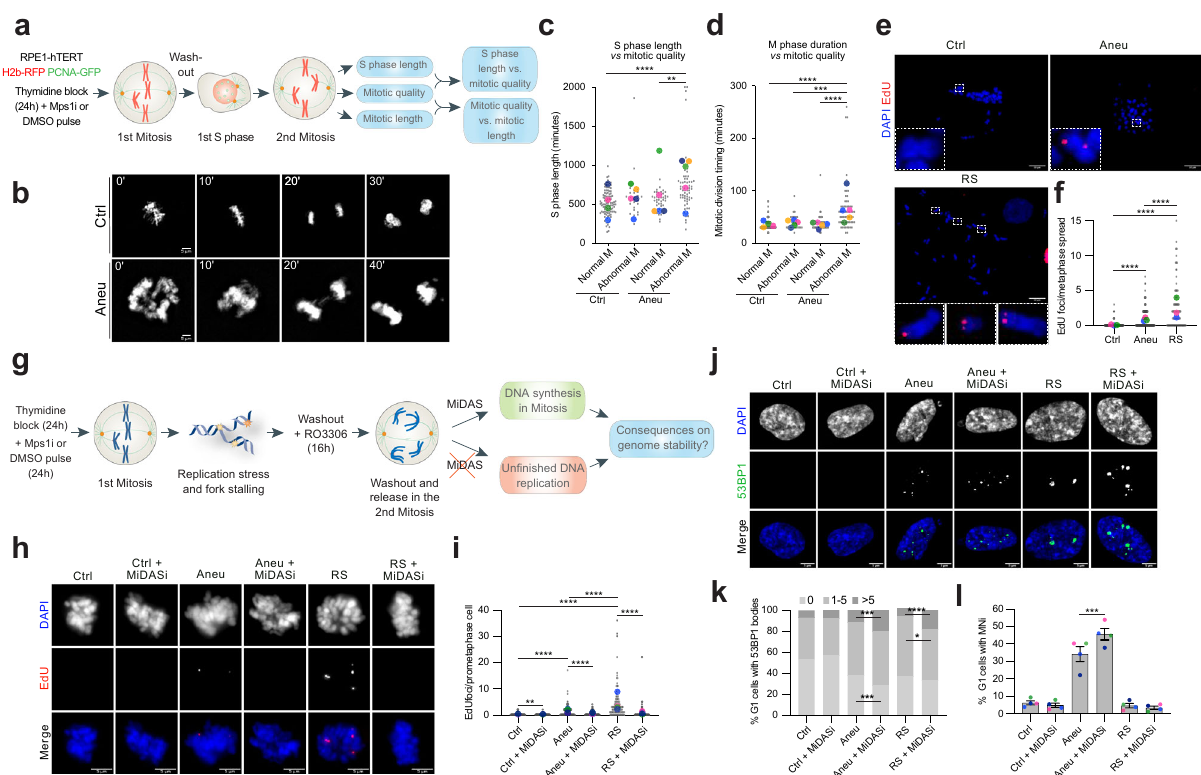
Fig.3|MiDASprotectsaneuploidcellsfromafurtherincreaseintheirgenome instability. a Experimental work fl ow for the analysis of the 1st S-phase duration, 2nd M phase duration and quality by live-cell imaging in hTERT RPE-1 cells expressing H2b-RFP and PCNA-GFP. b Representative images from the movies of mitosis duration and quality in control and aneuploid cells. For illustration pur- poses, images were deconvoluted by using the Huygens software using the deconvolution express function. Correlation between ( c ) S-phase duration and quality of the subsequent mitosis and ( d ) mitotic timing and mitotic quality in control(for( c ): n =98forCtrlNormalM, n =27forCtrlAbnormalM;for( d ): n =98 for Ctrl Normal M, n =34 for Ctrl Abnormal M) and aneuploid (for ( c ): n =43 for Aneu Normal M, n =63 for Aneu Abnormal M; for ( d ): n =43 for Aneu Normal M, n =62forAneuAbnormalM)cells.Representativeimages( e )andquanti fi cation( f ) of EdU incorporation on metaphase spreads in control ( n =129) and aneuploid ( n =167) cells. Cells treated with aphidicolin (RS, replication stress) were used as a positivecontrol( n =106).****indicates p <0.0001. g Experimentalwork fl owforthe assessmentofgenomeinstabilityinthefollowingG1phaseuponMiDASinhibition. Representative images ( h ) and quanti fi cation ( i ) of EdU incorporation in prome- taphase cells upon MiDAS inhibition ( n =130 for Ctrl, n =113 for Ctrl+MiDASi, n =156 for Aneu, n =116 for Aneu+MiDASi). Cells treated with aphidicolin (RS,